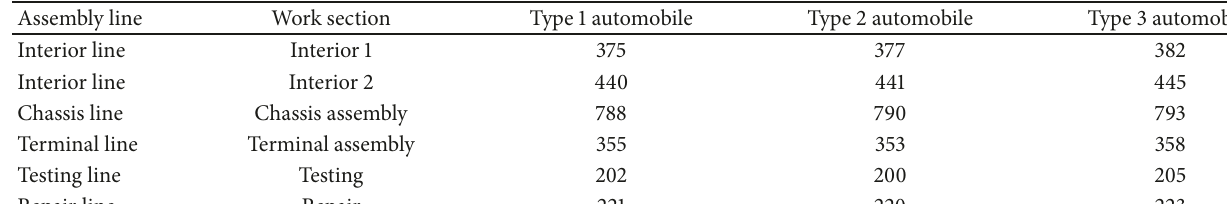
Table 2: Time parameter setting (unit: s).